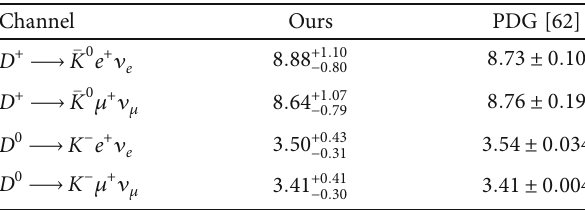
Table 6: Branching ratios (in %) for D ⟶ K ℓ ν obtained from using m ± 0 : 011